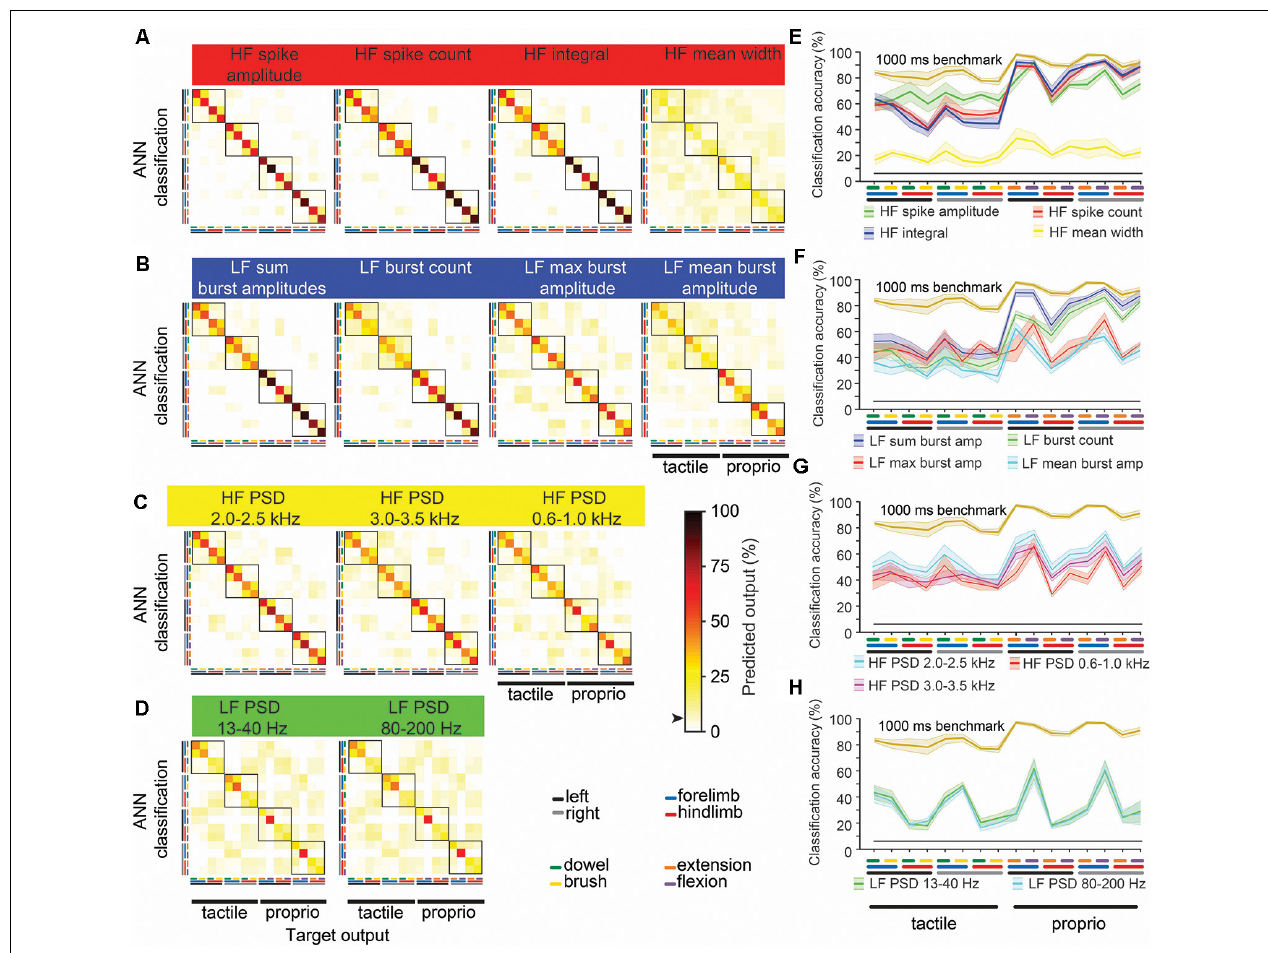
FIGURE 4 | Machine-learning outcomes for individual and combinations of 1,000 ms window benchmark features. Panels (A–D) shown are confusion matrices (mean of six animals) of machine-learning outcomes from 13 features comprising the benchmark feature set ( Figure 3A ) grouped by their four categories ( Figure 2 ). Features in the left column were the first four features combined (blue curve, Figure 3B ), and each confusion matrix to the right shows successive additions to the feature set. The black arrow on the color bar below confusion matrices indicates a chance level (6.25%). (E–H) The diagonal of each confusion matrix is plotted in the line graphs, with features in (A–D) corresponding to line graphs (E–H) , respectively. Dark lines in (E–H) show means of six animals and the corresponding pale bars indicate ± SEM; colors that are arbitrarily chosen. Superimposed is the benchmark feature-learnability (gold) for comparison; black straight lines indicate classification chance level (6.25%). See Figure 2 for feature